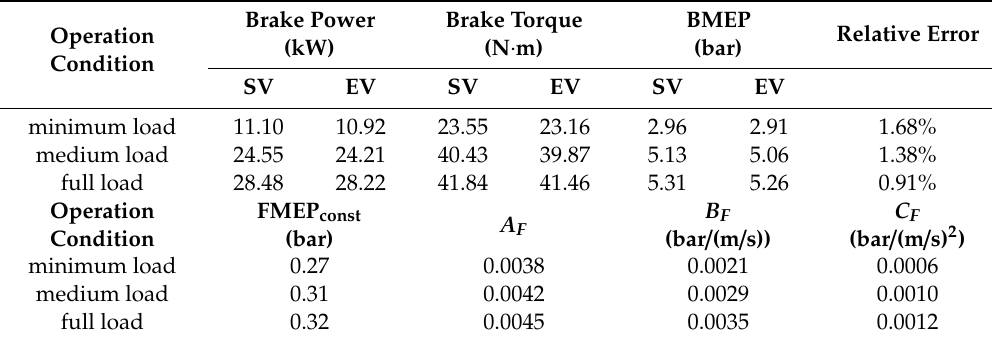
Table 13. Calibration results of friction loss model.